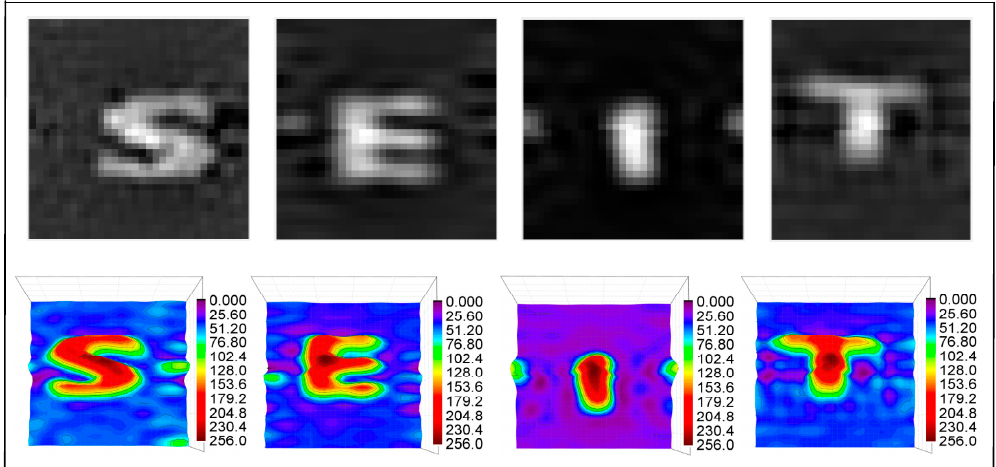
Figure 7. Experimental results. The top row is the reconstructed images. The bottom row is the 3D displays of the reconstructed images.